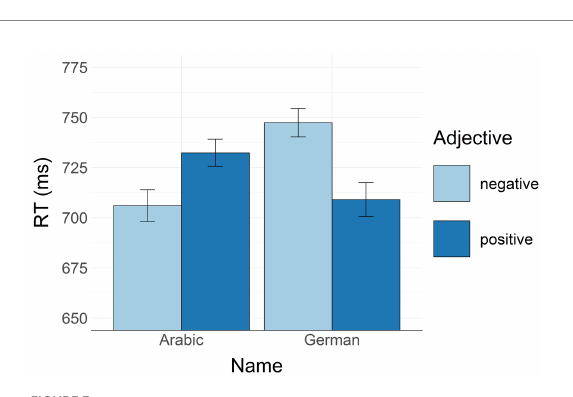
Figure 2 for descriptive statistics.